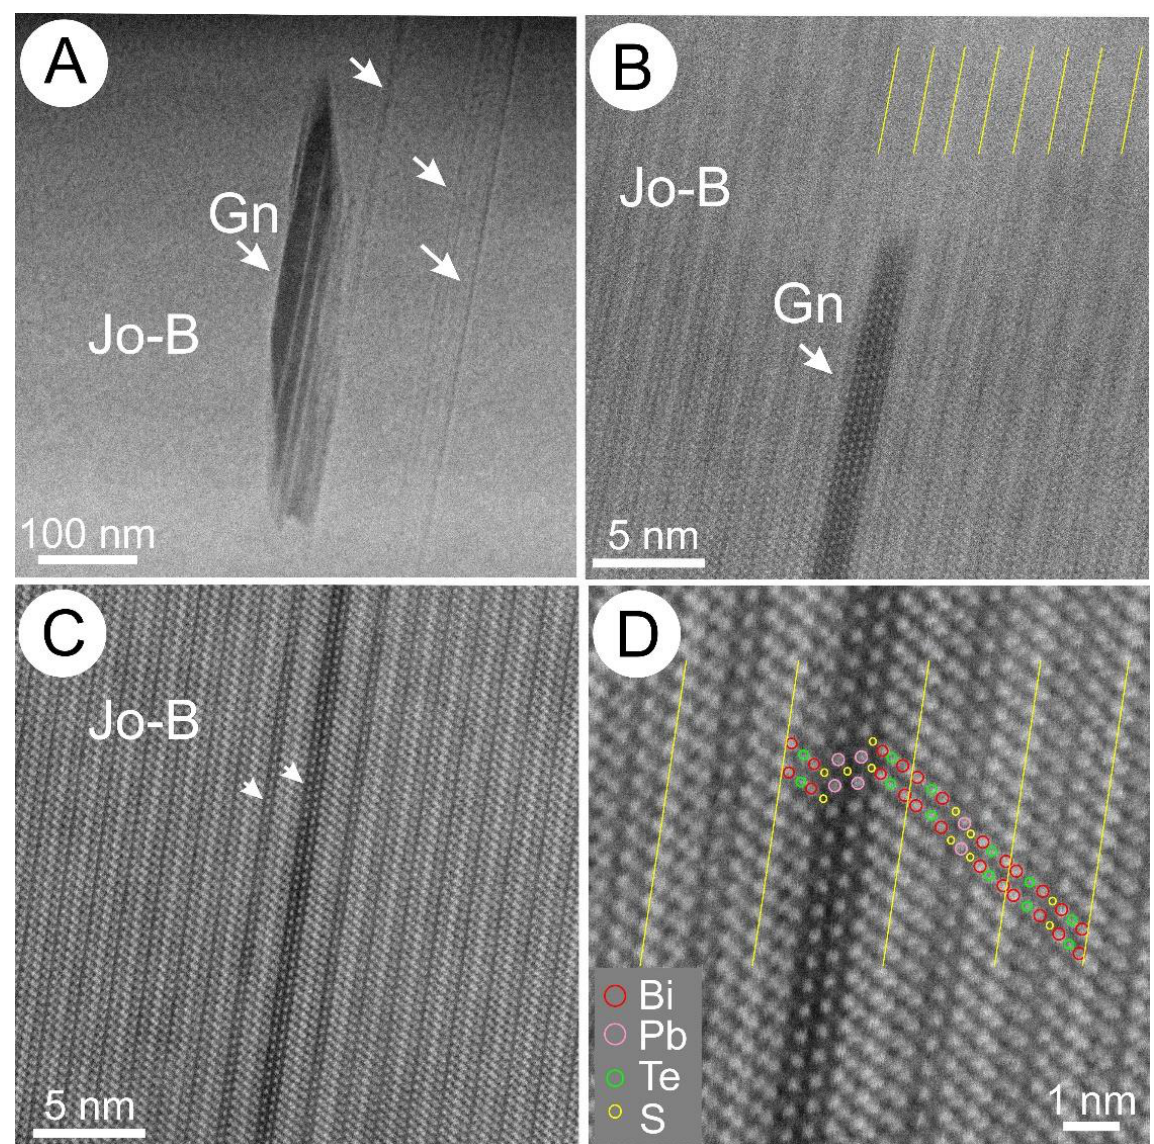
Figure 10. HAADF STEM images showing nanoscale inclusions of galena (Gn) within joséite-B (Jo-B). ( A ) Sets of parallel galena units (arrowed) in the vicinity of a larger galena inclusion. ( B ) Termination of a galena strip (5-PbS units) against two sequences of seven-atom layers in joséite-B. ( C ) Single and double Pb arrays (arrowed) inserted within the centre of a seven-atom layer of joséite-B. ( D ) Detail of layer intergrowths in (C) with atom overlay showing how the PbS [110] units are incorporated within the existing seven-atom sequence.